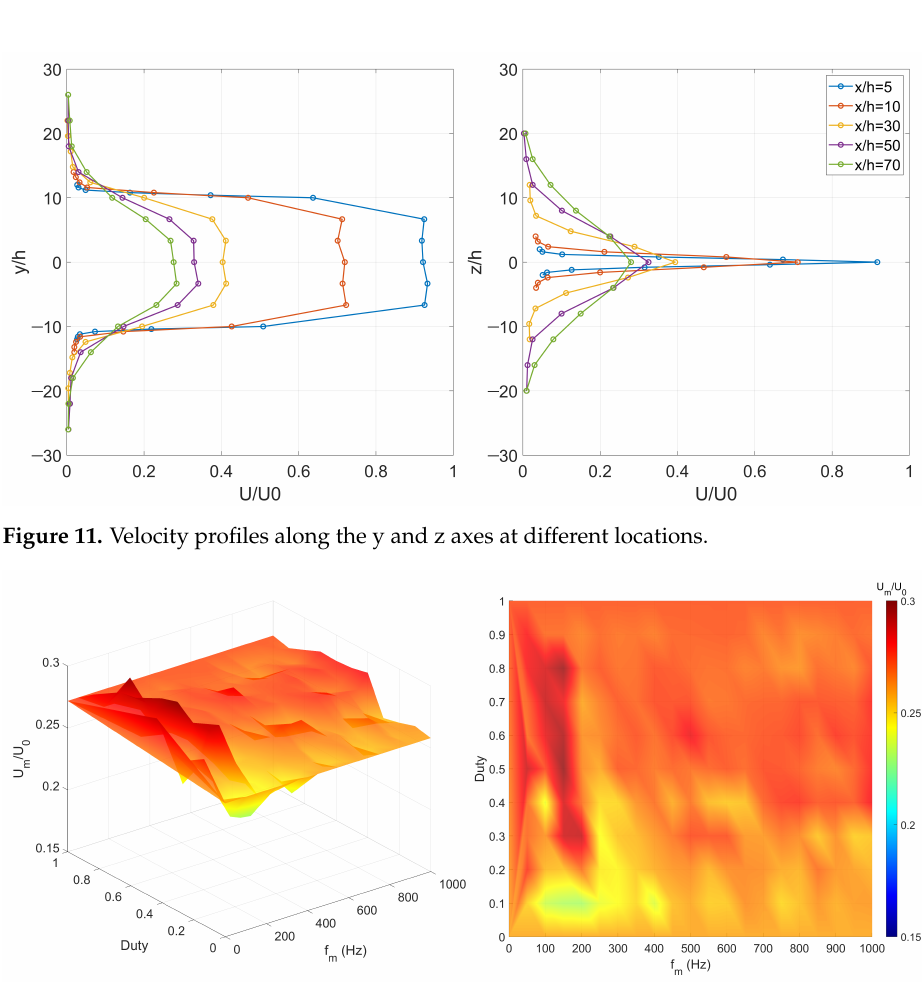
Figure 12. Surface plot and heat scatter plot ( f m vs. duty vs. velocity ) while θ = 0 at centerline where x / h = 70.